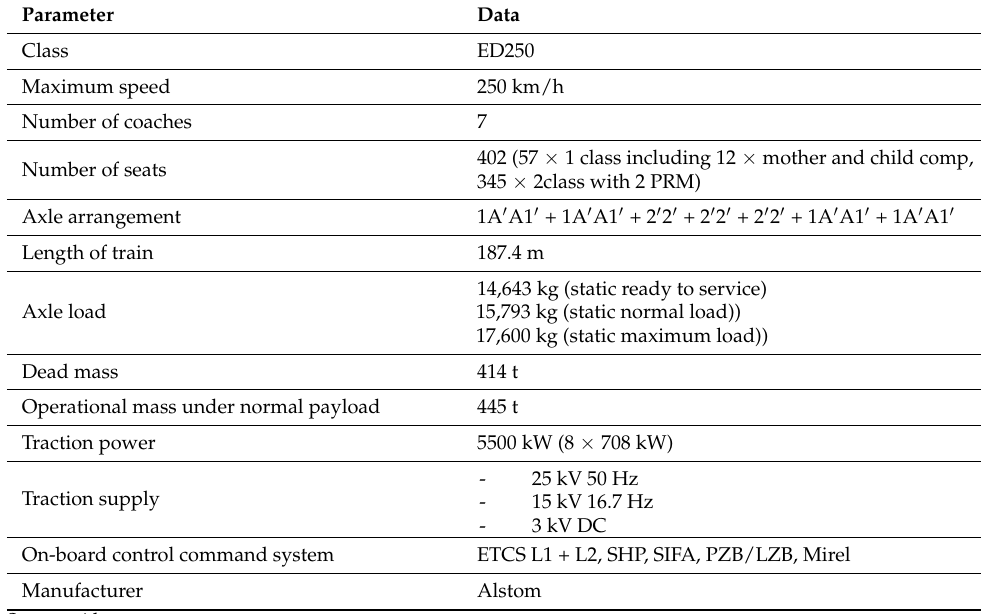
Table 1. ED250 technical